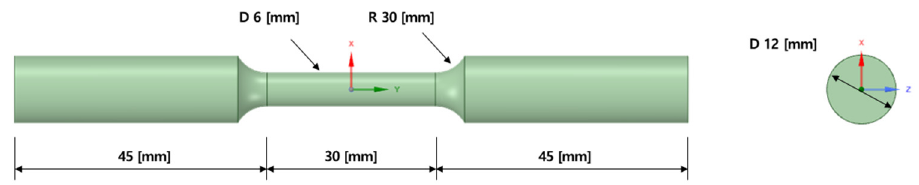
Figure 7. Dimensions of tensile specimens designed to ASTM E8 standards.